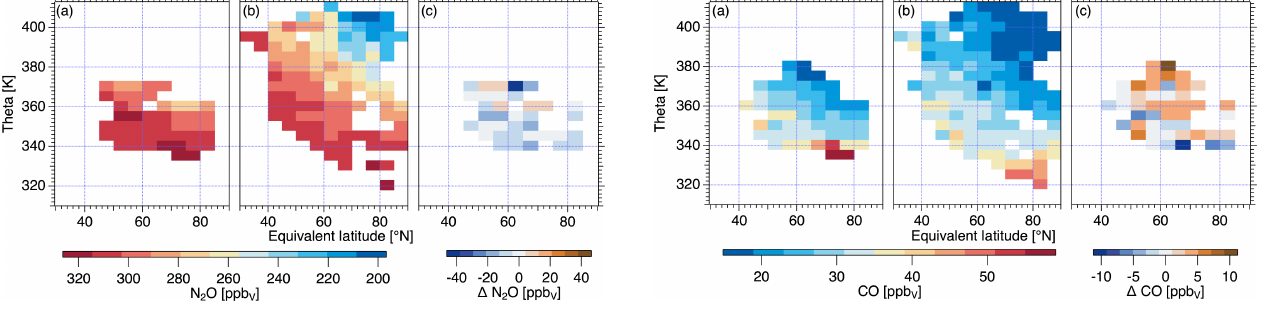
Figure 4. As in Fig. 3 but for N 2 O. Negative (blue) values in panel (c) indicate an overall decrease in N 2 O in the measurement region in accordance with increasing mean age (Fig. 3c).